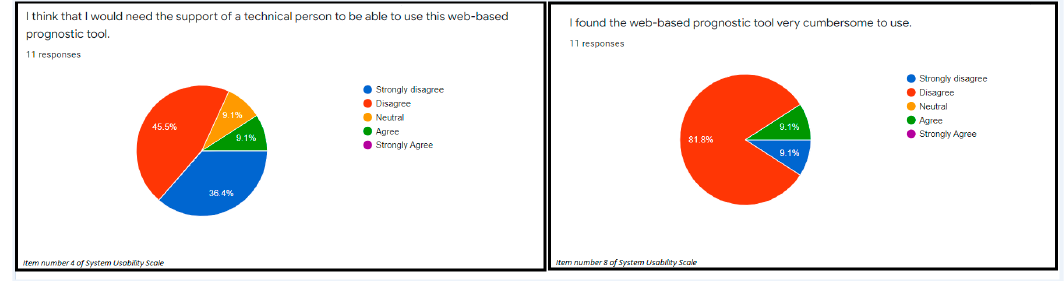
Figure 1. The usability of a web-based prognostic tool using items number 4 and 8 of the System Usability Scale.